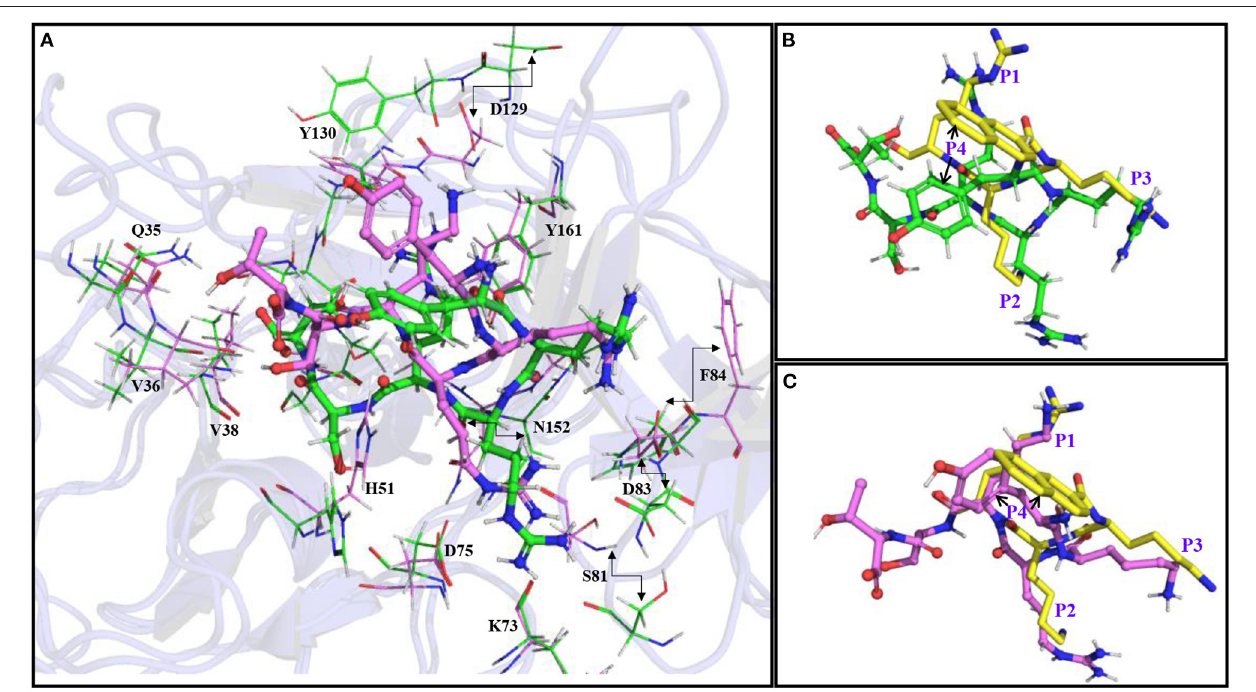
FIGURE 5 | (A) Superimposition of the average simulated structure of the YRRRST-protease complex (carbon atoms are shown in green) onto the average simulated structure of the YKRKST-protease complex (carbon atoms are shown in violet). (B) Superimpositions of the average simulated structures of the YRRRST-protease complex and (C) YKRKST-protease complex onto the peptidomimetic–protease complex containing KKR (PDB ID 5ZMQ) (carbon atoms in yellow). The movements of some residues during the simulations are indicated by arrows. The P1–P4 residues of the inhibitors are labeled in (B,C)